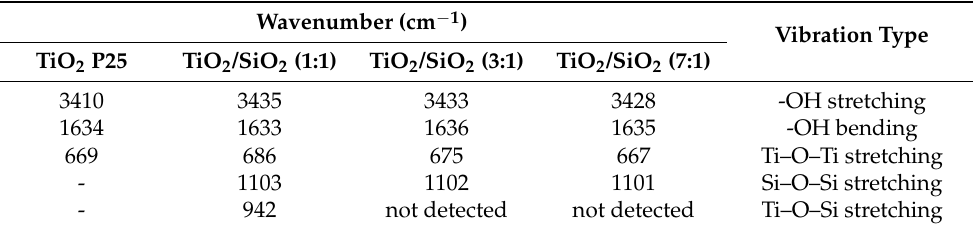
Figure 2. FTIR spectra of ( a ) TiO 2 P25, ( b ) TiO 2 /SiO 2 composite 1:1 ratio, ( c ) TiO 2 /SiO 2 composite 3:1 ratio, and ( d ) TiO 2 /SiO 2 composite 7:1 ratio. Table 4. Types of vibrations in TiO 2 P25, TiO 2 /SiO 2 composites with the ratio variation of 1:1, 3:1, and 7:1 based on the peaks that appear in each wavenumber.